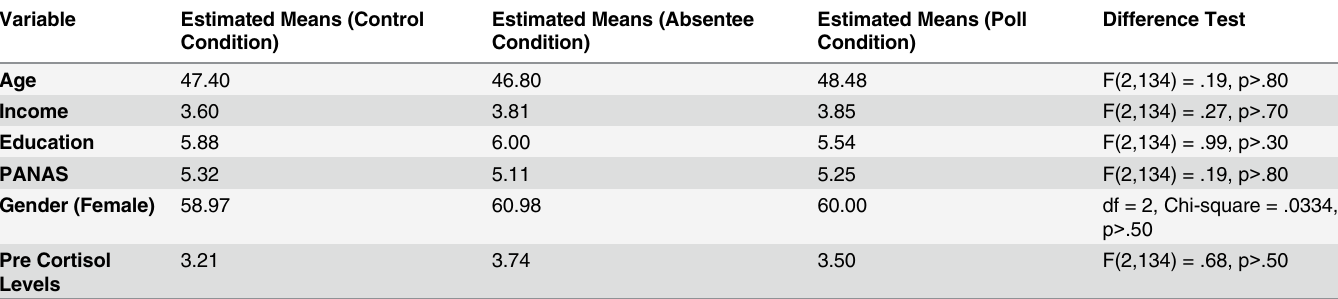
Table 2. Testing for Equivalency Differences Between Experimental